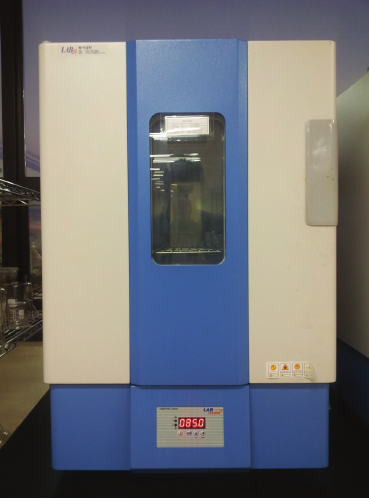
Figure 6: Heat test chamber.